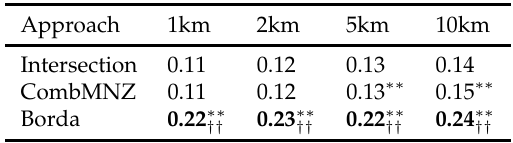
Table 3: MAP (reported to two decimal places) for three results lists combinations applied to GGD. Symbol ** denotes a significant difference ( p < 0 . 001 , Students T-test) compared with Intersection. Similarly symbol †† denotes a significant difference with CombMNZ.